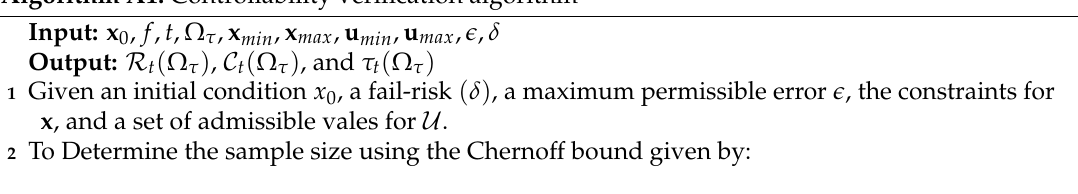
Algorithm A1: Controllability verification